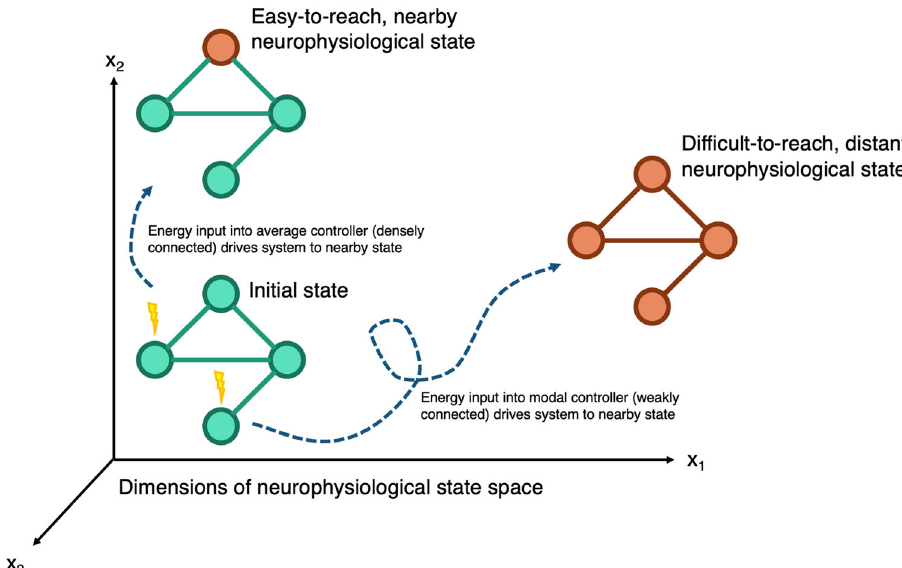
Fig. 1 Schematic of network control theory, illustrating concepts of average and modal controllability. Brain networks exist in a neurophysiological state space, where the state is de fi ned as the inferred magnitude of neurophysiological activity at a given time. Nodes with high average controllability tend to be densely connected and drive the system to nearby, easy-to-reach neurophysiological states. Nodes with high-modal controllability tend to be weakly connected and drive the system to distant, dif fi cult-to-reach neurophysiological states.